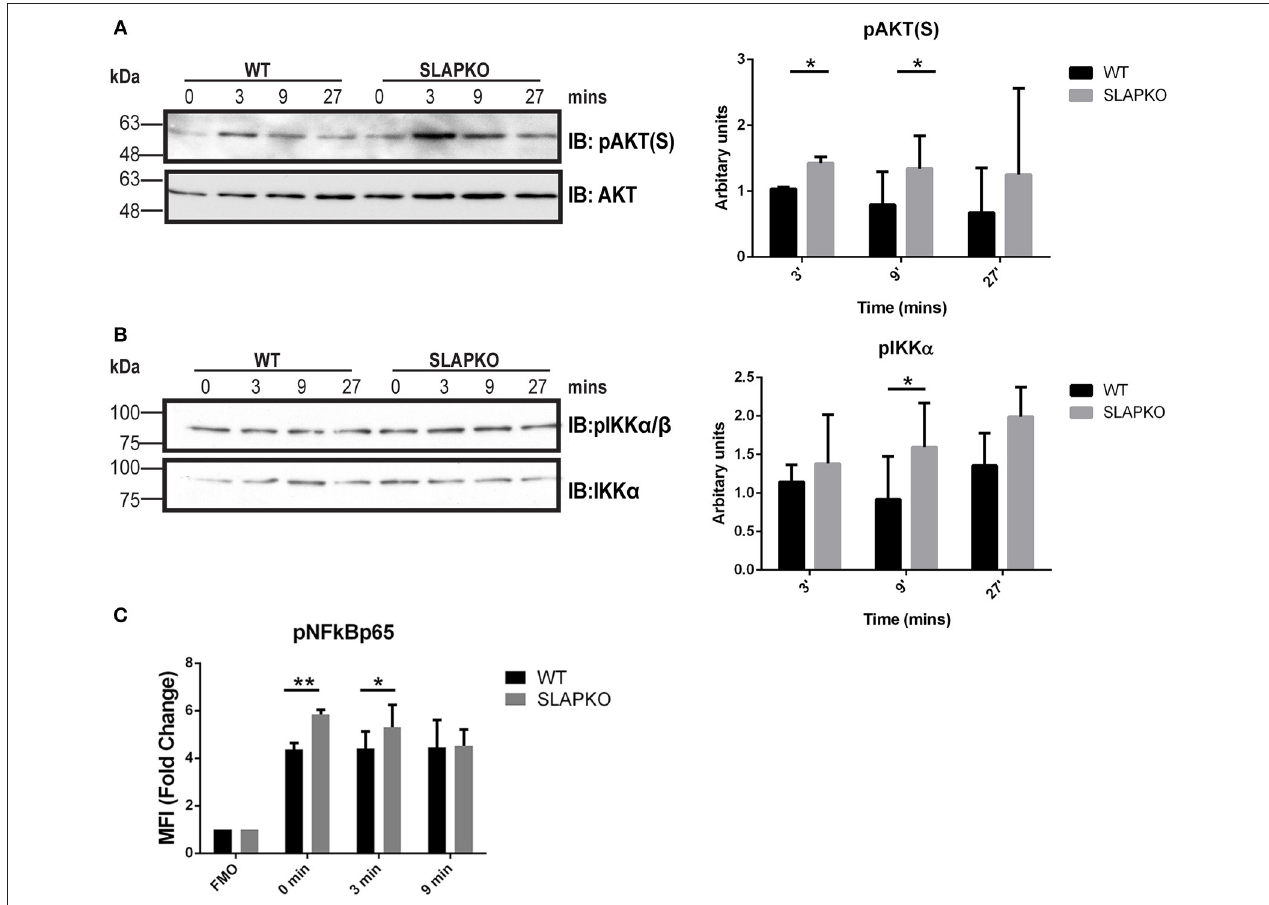
FIGURE 7 | SLAP negatively regulates AKT- NF κ B signaling downstream of Fc ε RI. WT and SLAP KO BMMCs were starved and sensitized with anti-DNP IgE for 18h and then stimulated with DNP-HSA (50ng/ml) for indicated time-points. (A) Lysates were prepared and subjected to immunoblot (IB) with anti-phospho-AKT serine 473 [pAKT(S)], and AKT Abs, (B) anti-p-IKK α / β , and IKK α Abs. Representative immunoblots are shown from three separate experiments ( n = 3). Positions of relative mass markers in kilodaltons (kDa) are shown on the left. Bar graph represents the quantitation of relative levels of indicated phospho-proteins at given time points by densitometry quantification. Data (mean ± SD) in bar graph represents the pooled data from three independent experiments ( n = 3) and compared with Student’s t -test; * P < 0.05. (C) WT and SLAP KO BMMCs were starved and sensitized with anti-DNP IgE and stimulated with DNP-HSA for indicated time-points, stained with pNF κ Bp65 Ab and median fluorescence intensity was quantified by phosphoflow. Bar graphs showing the average of normalized MFI (fold change) in phosphorylation of NF κ B65 at indicated time-points compared to respective fluorescence minus one (FMO) control from each genotype. Data (mean ± SD) in bar graph represents the pooled data from three independent experiments ( n = 3; Student’s t -test; * P < 0.05; ** P <